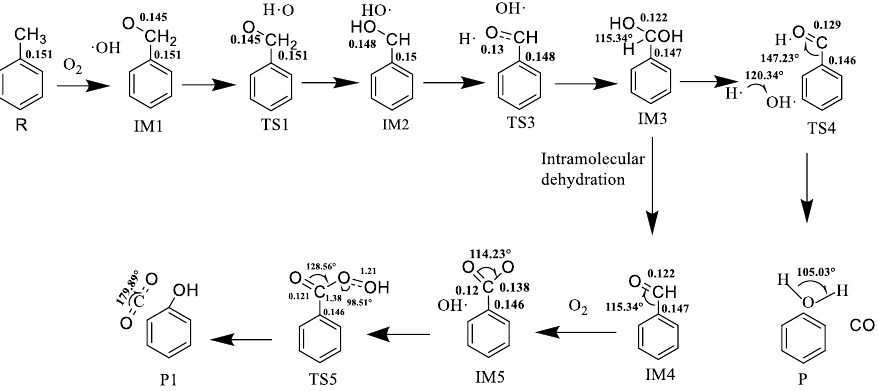
Figure 2. Structural model of methyl radical reaction with oxygen (key length unit: nm; bond angle unit: °).